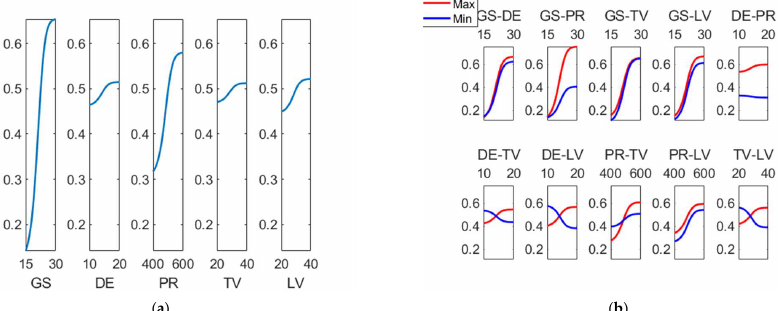
Figure 9. ( a ) Main effects plot and ( b ) interaction effects plot for (Rpk (µm)).